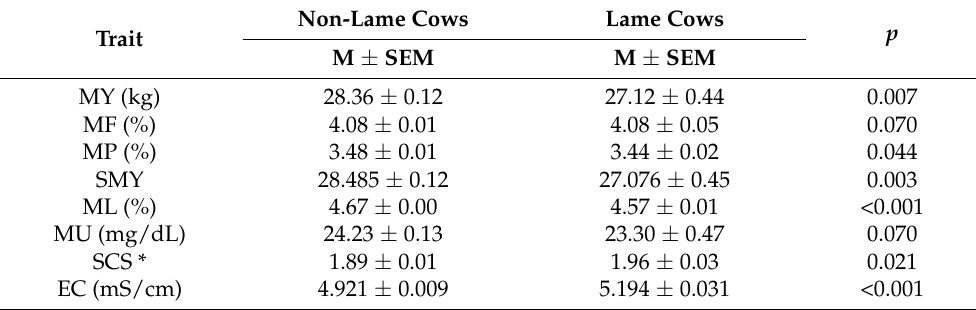
p indicates the reliability of the difference between the groups, and n.s. indicates that the difference is unreliable. MY: milk yield; MF: milk fat; MP: milk protein; MU: milk urea; SMY: standard milk yield (0.4 × MY + 15 × MF × MY); ML: milk lactose; EC: milk electric conductivity; SCS *: the logarithmic expression of somatic cell count in milk (SCC): SCS = (log2 (SCC/100)) + 3. The average milk lactose concentration in non-lame cows in the current study was 0.1% higher than in lame cows ( p = 0.04). In the group of healthy cows, 8.2% more animals with ML ≥ 4.6% were